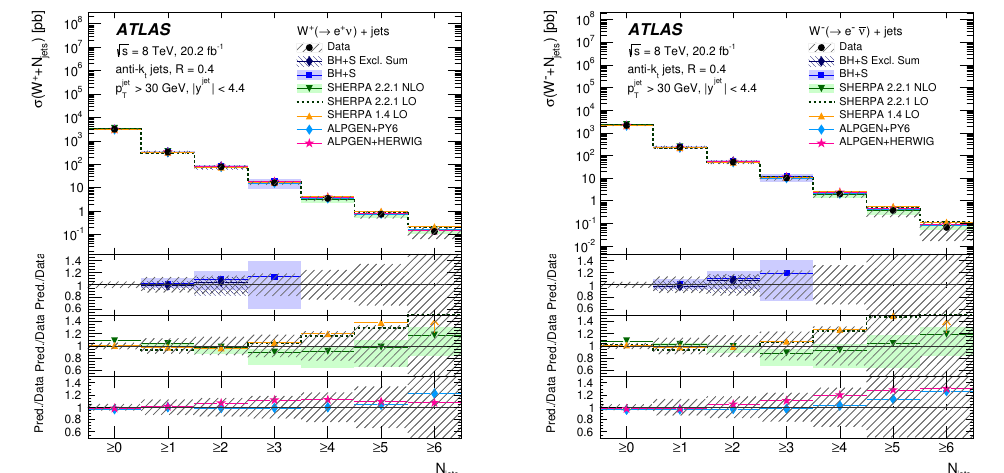
Figure 16 . Di(cid:11)erential cross sections for the production of W + (left) and W (cid:0) (right) as a function of the inclusive jet multiplicity. For the data, the statistical uncertainties are indicated as vertical bars, and the combined statistical and systematic uncertainties are shown by the hatched bands. The uppermost panel in each plot shows the di(cid:11)erential cross sections, while the lower panels show the ratios of the predictions to the data. The theoretical uncertainties on the predictions are described in the text. The arrows on the lower panels indicate points that are outside the displayed range.